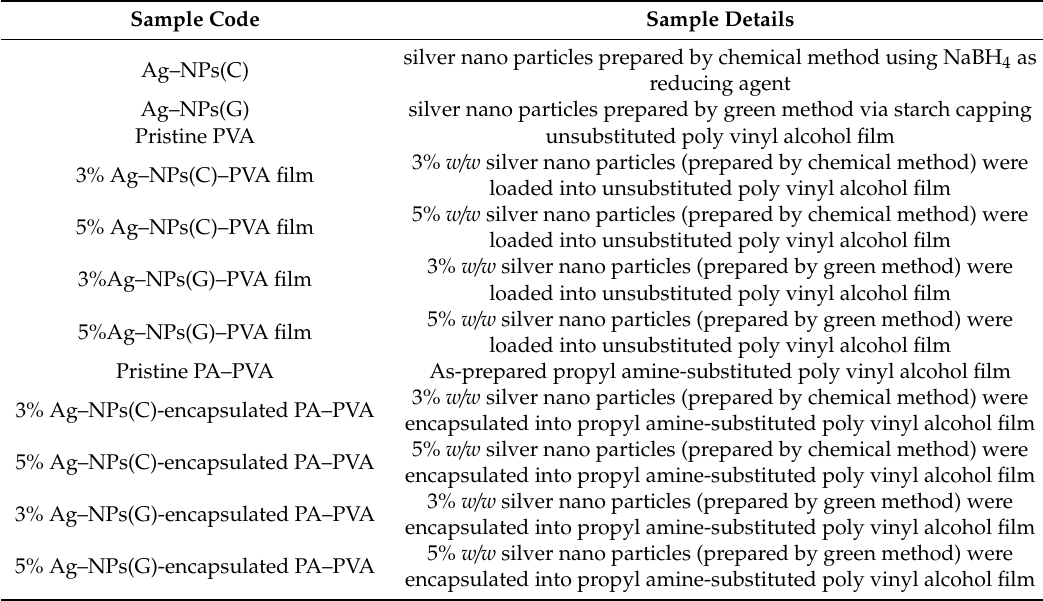
Table 1. Details of all prepared samples.